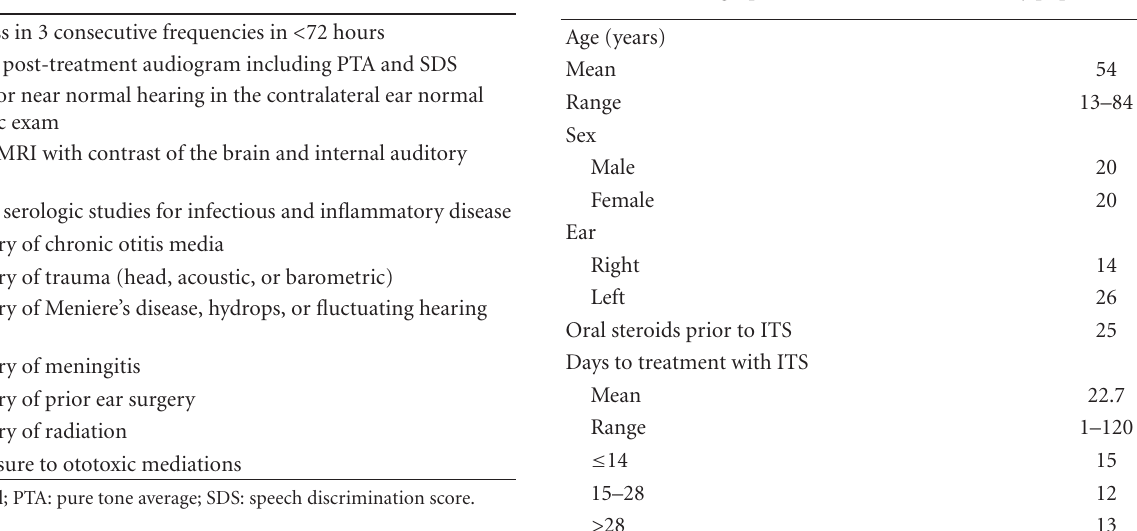
Table 1: Inclusion and exclusion Criteria. Table 2: Demographic characteristics of the study